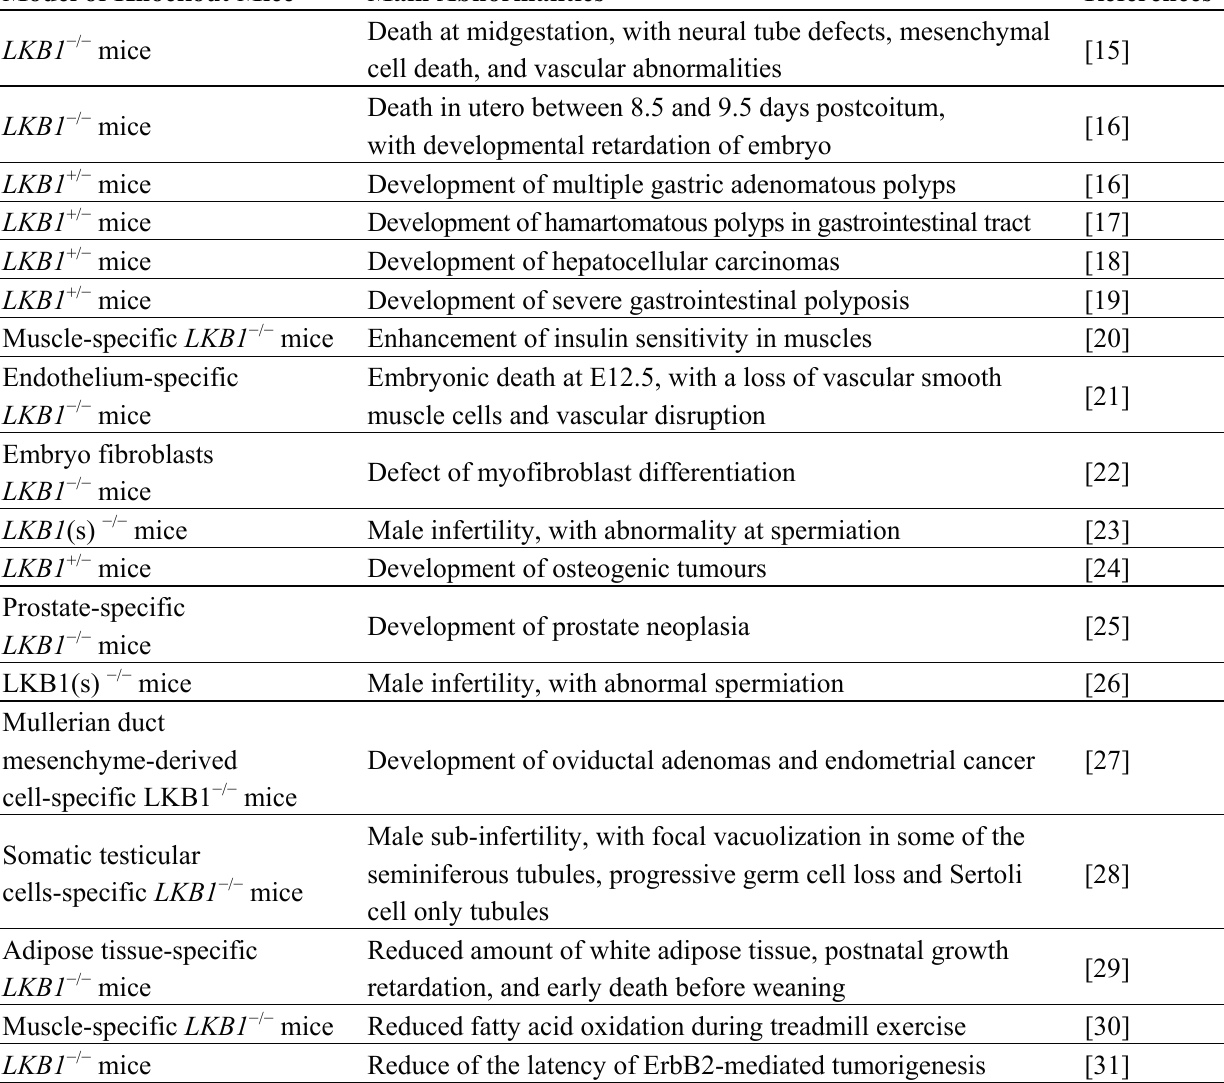
Table 1. Abnormalities of LKB1 knockout